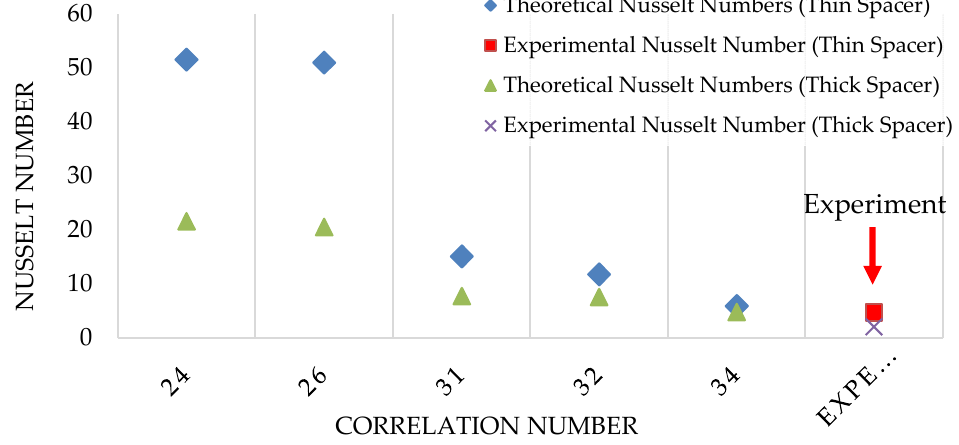
Figure 15. Correlations for spacer-filled channels with flow rate (3 L/min).